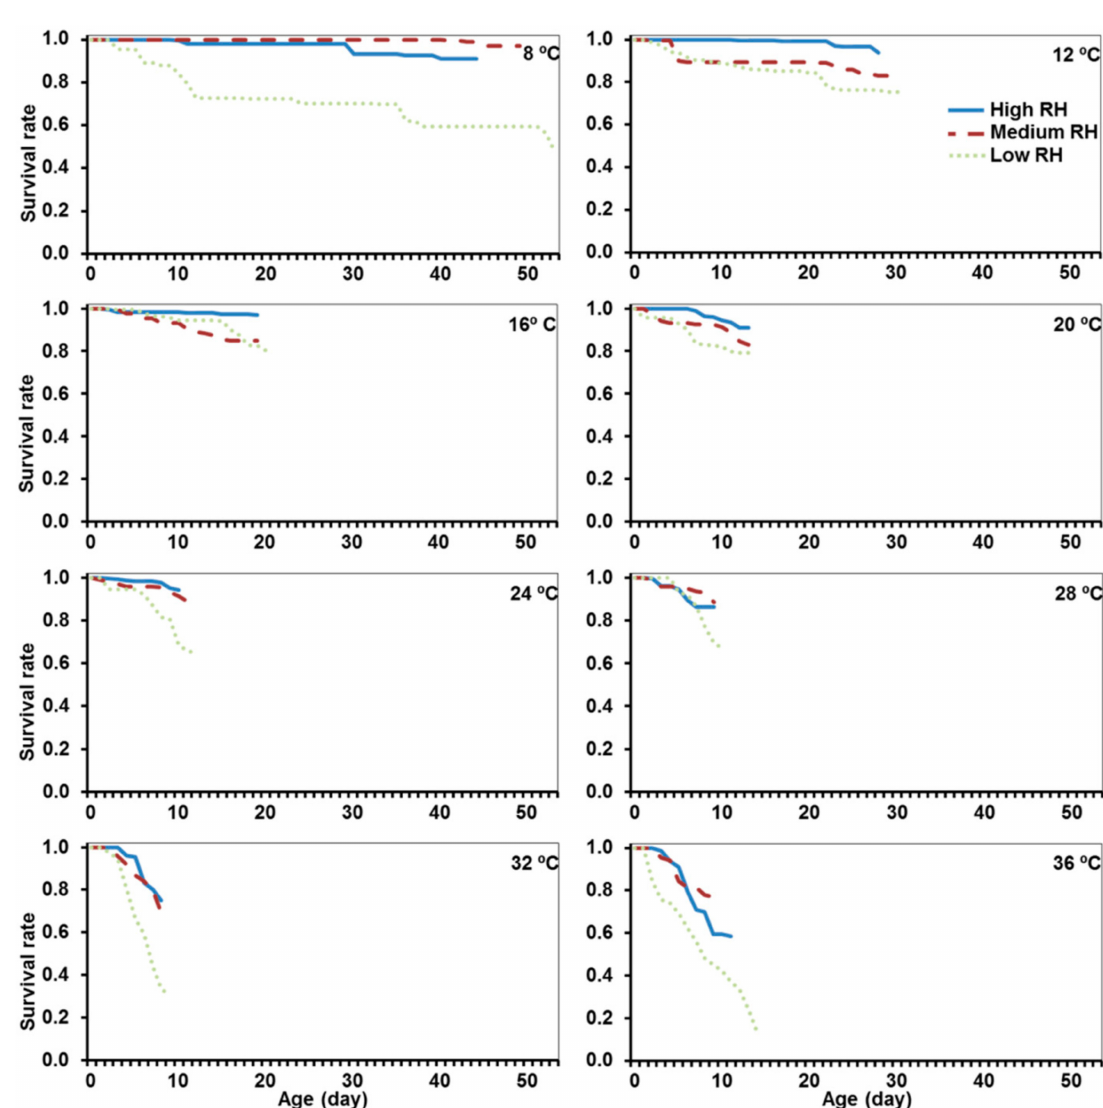
Figure 1. The age-specific survival rate ( lx ) of Hypera postica eggs at different temperatures (from 8 to 36 ◦ C) and three relative humidity (RH) regimes (high: 90% < RH < 100%; medium: 50% < RH < 75%; and low: 10% < RH < 35%). The blue line refers to the high humidity regime; the dashed red line to the medium humidity regime, and the light green dashed line to the low humidity